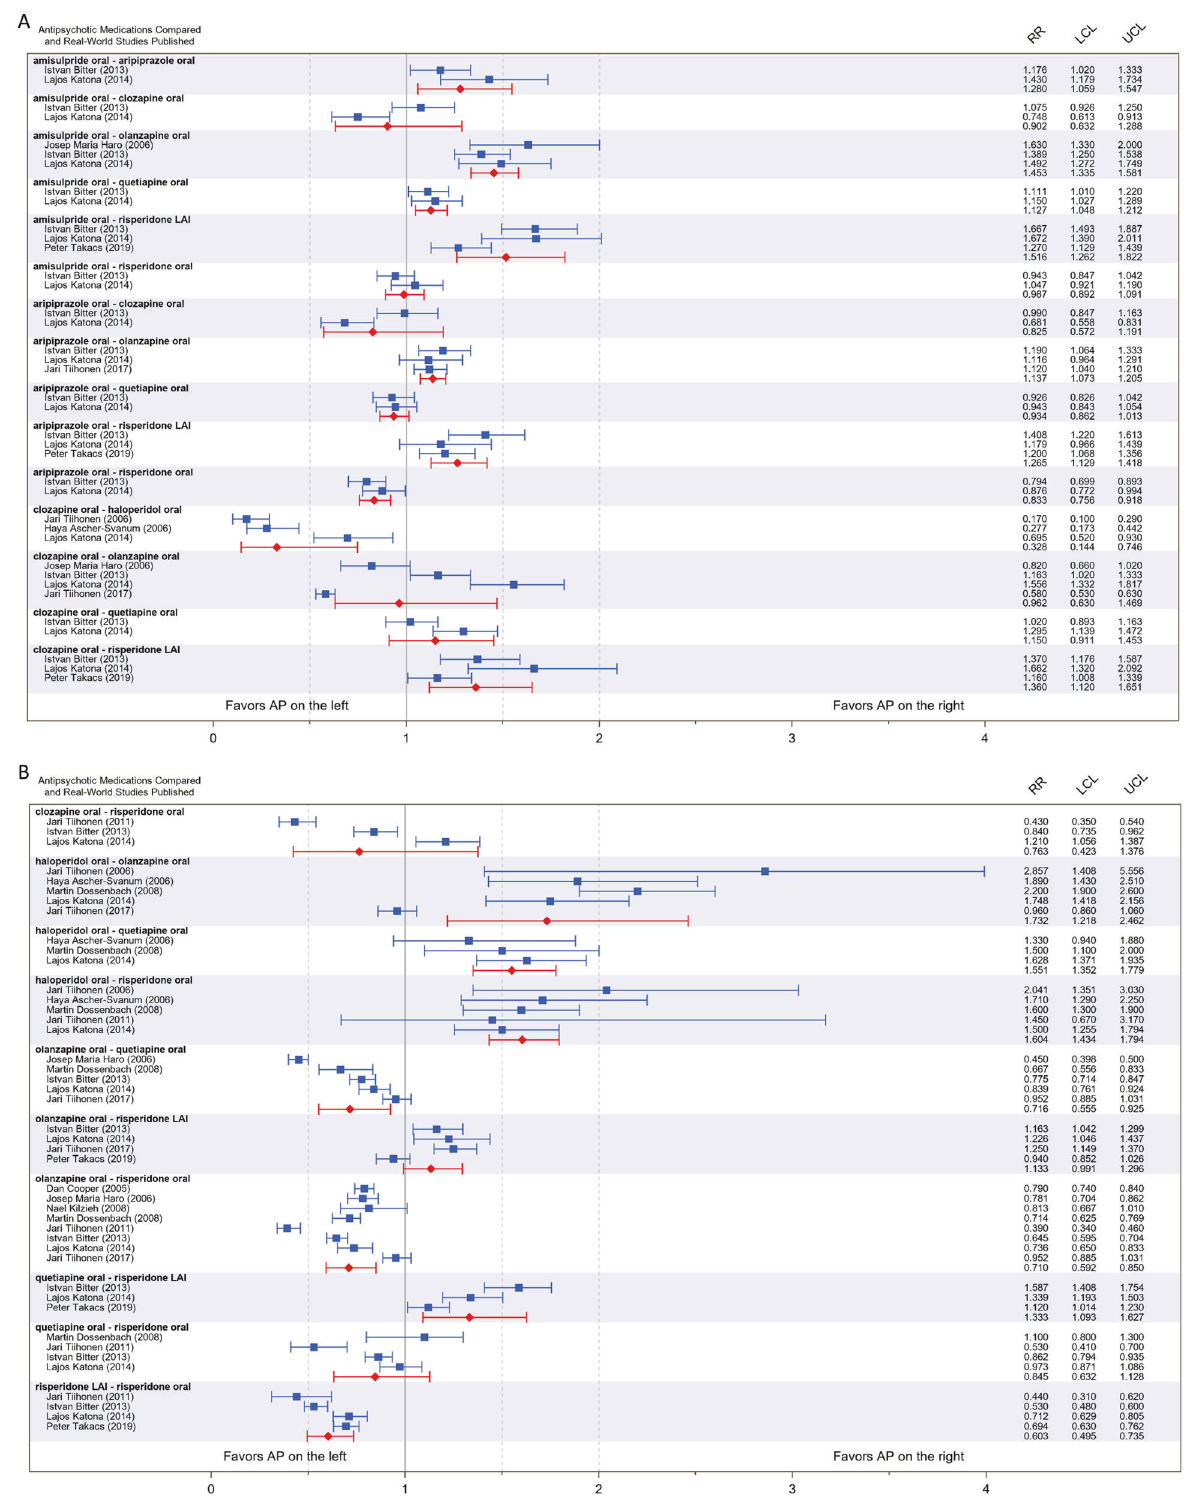
groups (29.4%) where the input data were heterogenous: CLO- OLA, CLO-RIS, HAL-OLA, OLA-RIS LAI, QUE-RIS. Speci fi cally, out of the 17 pair-wise comparisons we found that 12 (70.6%) provided both statistically conclusive and consistent evidence for the relative superiority of the respective APs in the comparisons. One of the comparisons (5.9%) yielded